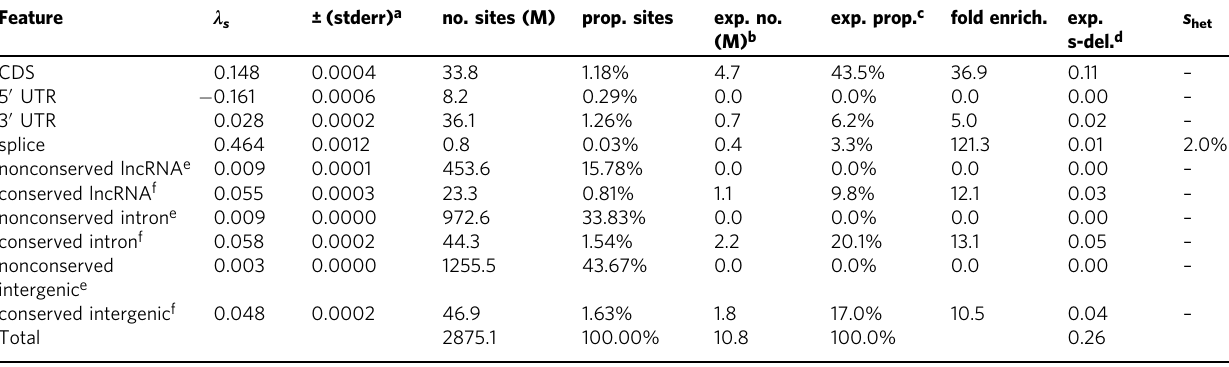
Table 1 Ultraselection across the human genome (based on